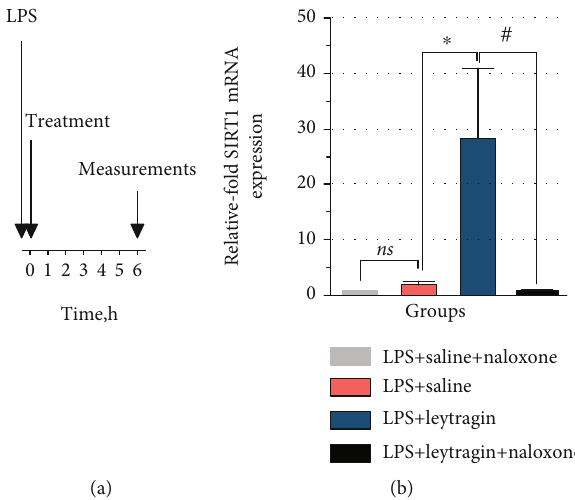
Figure 5: Naloxone abrogates the e ff ects of leytragin on SIRT1 mRNA levels in LPS-induced mice. (a) Scheme of experiment. (b) The relative levels of SIRT1 mRNA transcription at the six-hour point after LPS installation; 5 animals per group were used; Ns: nonsigni fi cant, ∗ p < 0 : 05 vs. LPS+saline, and # p < 0 : 05 vs. LPS+leytragin+naloxone, one-way ANOVA followed by Tukey ’ s post hoc test (see the text). Bars represent the mean ± SEM